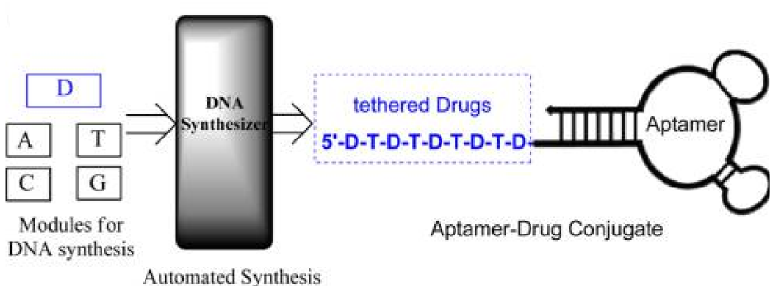
Figure 6. Schematic illustration of automated and modular chemical synthesis of aptamer-drug conjugates (ApDCs) from phosphoramidites A, T, C, G and D. Reprinted with permission from © (2014) American Chemical Society